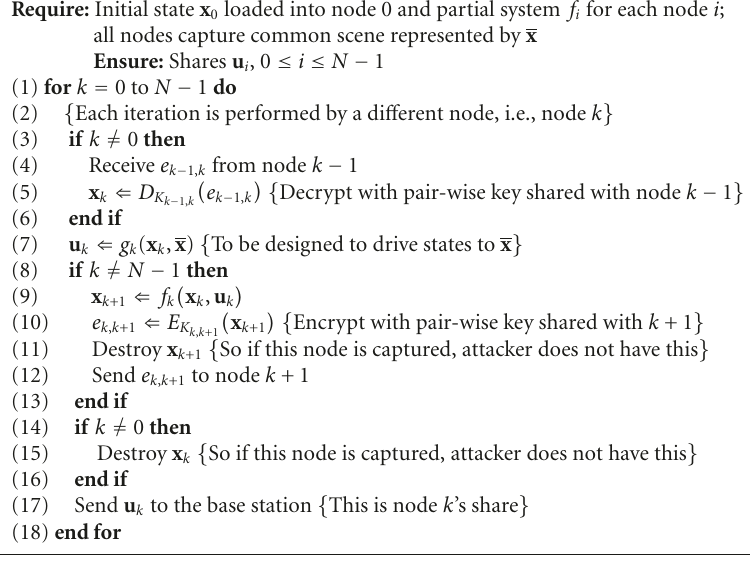
Algorithm 1: Distributed encryption for